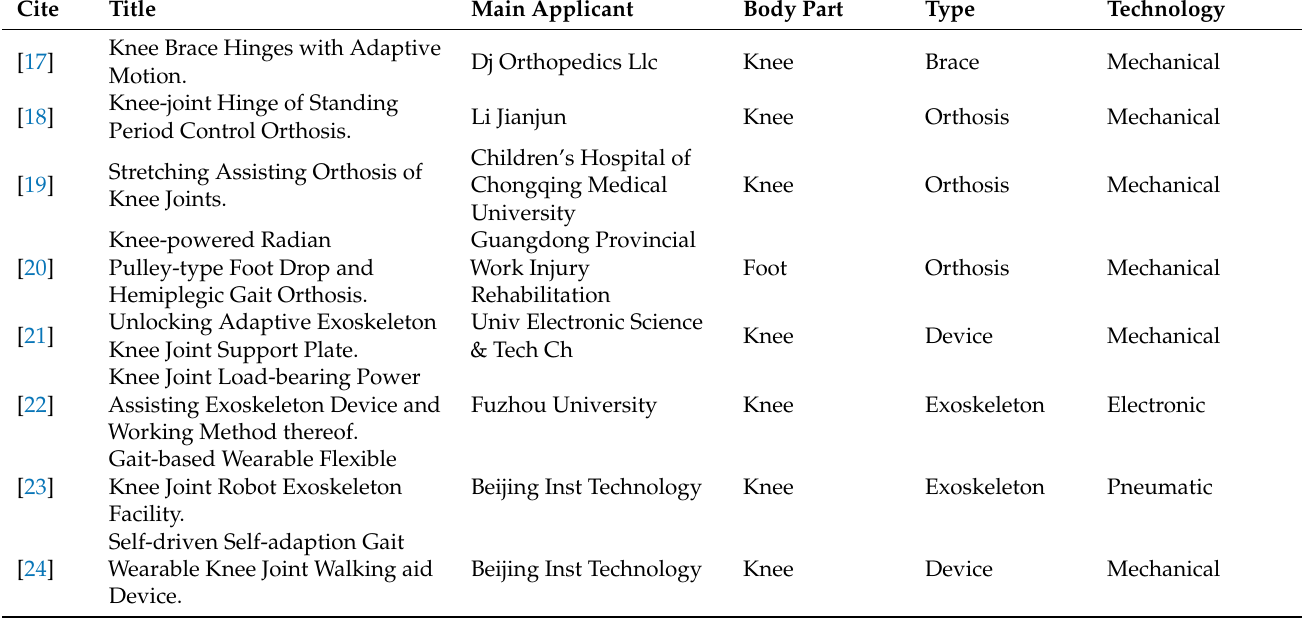
Table 3. Lower limb exoskeletons and orthoses